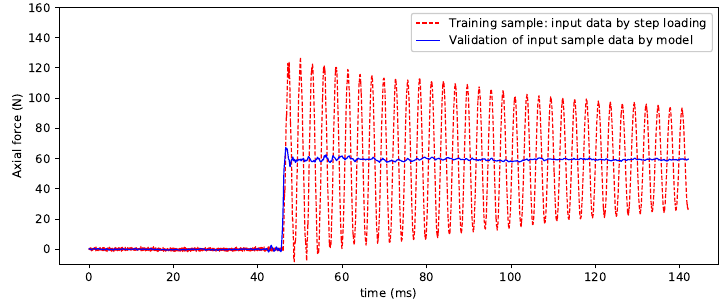
Figure 8. Input sample data and validation by CNN model (axial force).